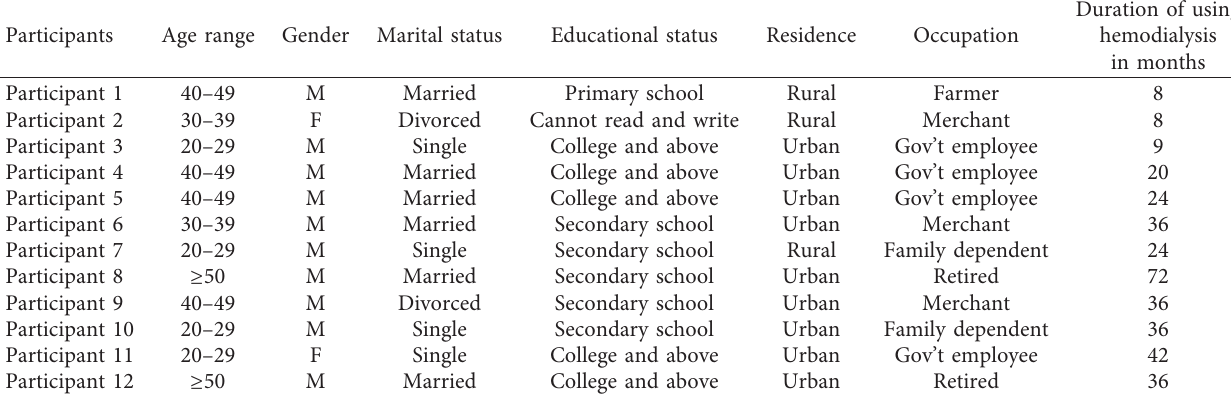
Table 1: Sociodemographic characteristics of participants in FHCSH Hemodialysis Center, Bahir Dar City, Northwest Ethiopia,